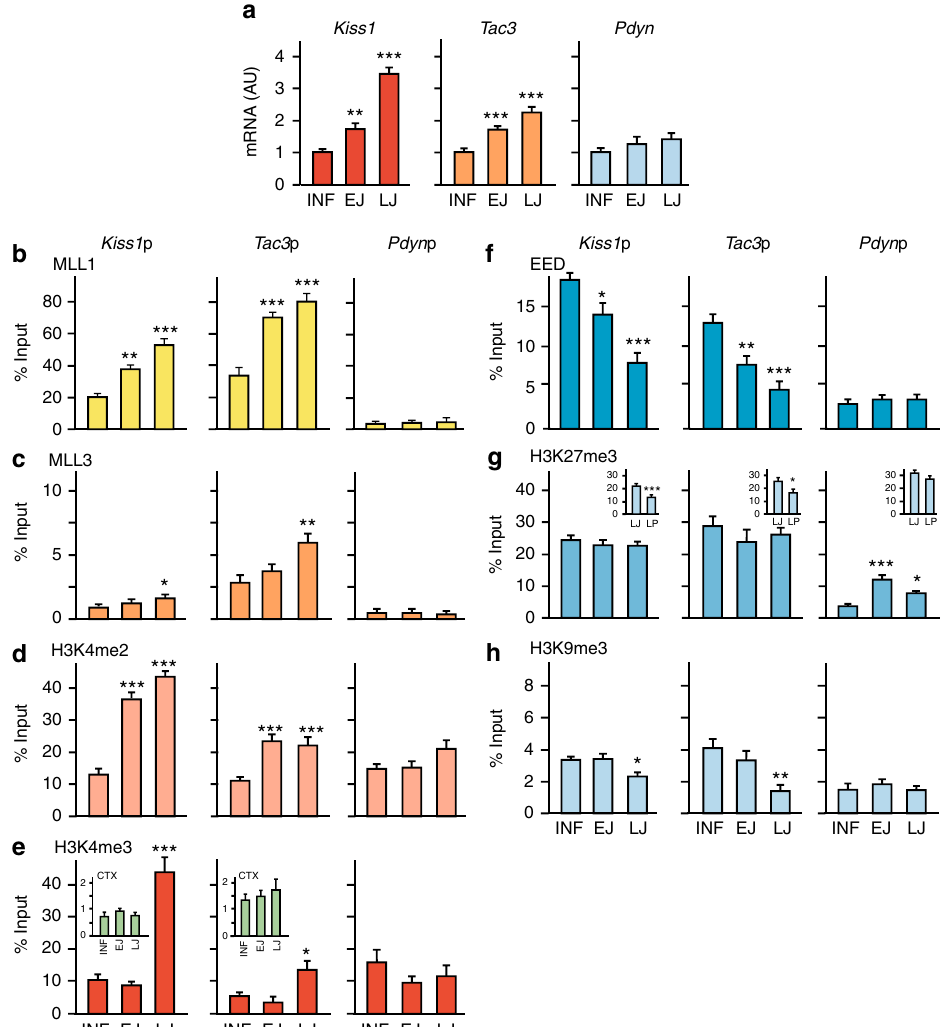
Fig. 3 Kiss1 , Tac3 , and Pdyn mRNA expression, and promoter chromatin state in the prepubertal female rat hypothalamus. a Expression of Kiss1 , Tac3 , and Pdyn mRNA in the MBH of prepubertal female rats as determined by qPCR. Bars represent mean ± s.e.m. (INF, EJ, and LJ; n = 8); AU = arbitrary units. RNA expression data were normalized by dividing each individual value by the average of the INF group. b Changes in MLL1 recruitment to the Kiss1 , Tac3 , and Pdyn promoters before puberty. c Changes in MLL3 recruitment to the Kiss1 , Tac3 , and Pdyn promoters before puberty. d , e Abundance of the TrxG- dependent activating marks H3K4me2 ( d ) and H3K4me3 ( e ) during prepubertal development. Insets in e depict H3K4me3 content at the Kiss1 and Tac3 promoters in the CTX during prepubertal development. f EED recruitment to the Kiss1 , Tac3 , and Pdyn promoters before puberty. g Abundance of the PcG- dependent repressive mark H3K27me3 at the Kiss1 , Tac3 , and Pdyn before puberty or at the time of the fi rst preovulatory surge of gonadotropins (late proestrus, LP) at the Kiss1 and Tac3 promoters (insets in g ). h Abundance of the PcG-independent repressive mark H3K9me3 at the Kiss1 , Tac3 , and Pdyn promoters before puberty. Bars represent mean ± s.e.m. (INF, EJ, and LJ; n = 5 – 8; insets in e ; n = 4; insets in g ; n = 6). * P < 0.05, ** P < 0.01, and *** P < 0.001 vs. INF; one-way ANOVA followed by SNK